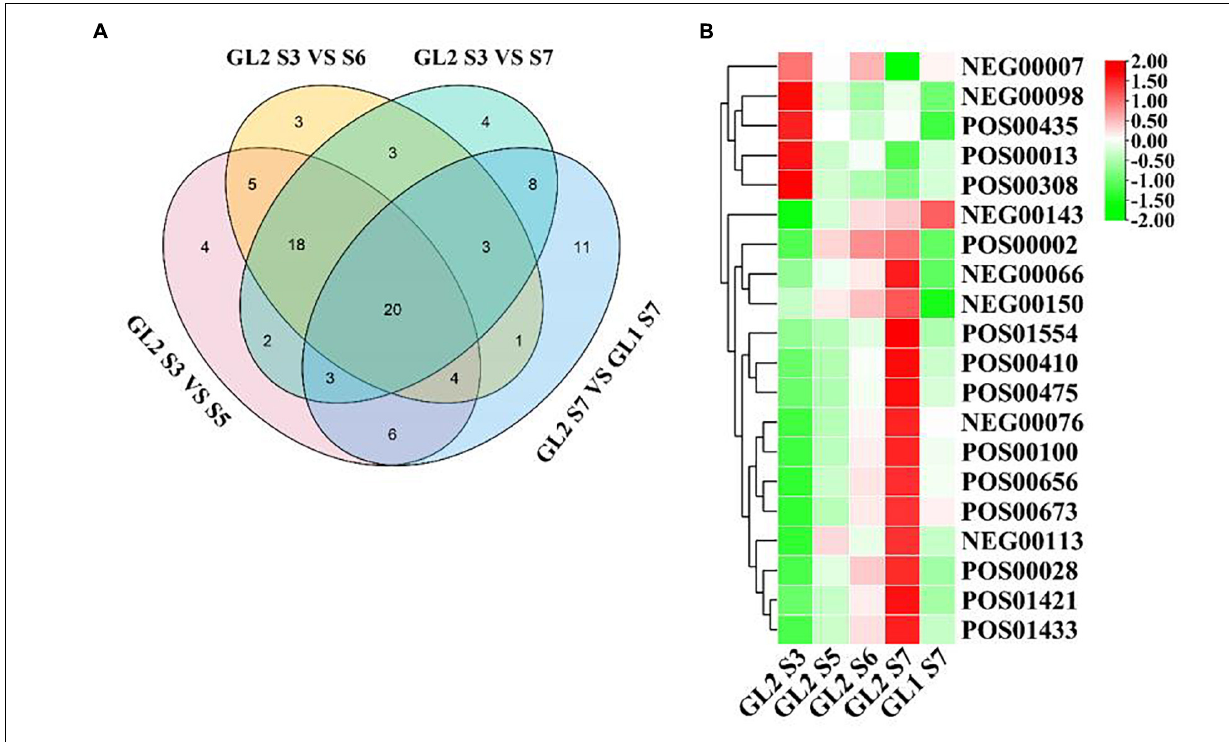
FIGURE 4 | Venn diagram analysis of metabolites related to the formation of early mature trait (A) and heat map of expression levels of metabolites (B) . In (A) the number represents the number of metabolites contained in each area. In (B) the bar on the right represents the normalized coefficient range of the expression level. The redder the bar, the higher the expression level, and the greener bar, the lower the expression level.